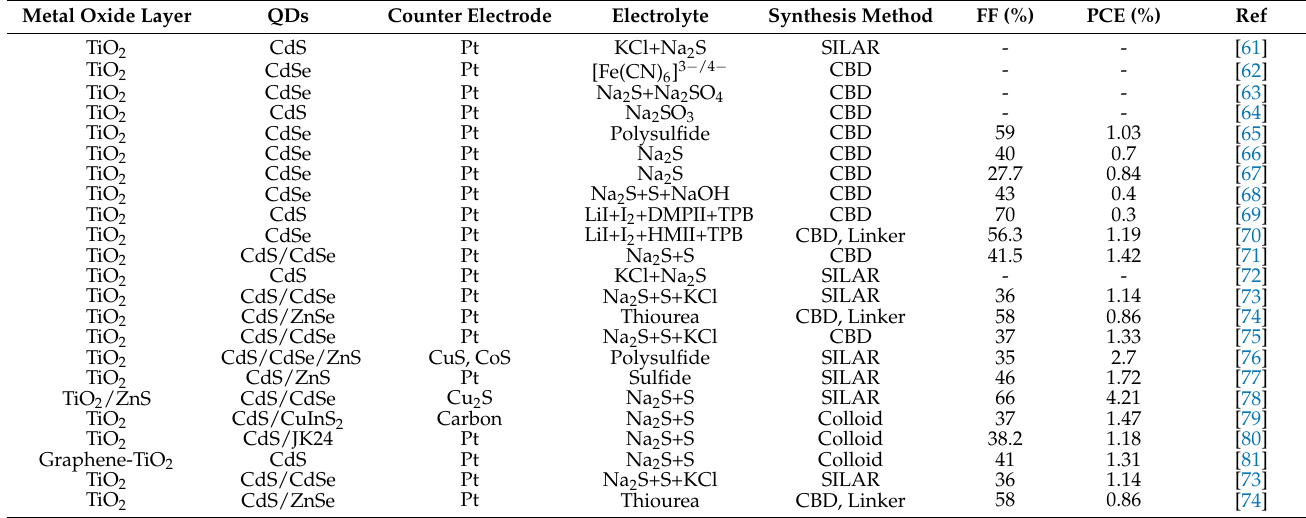
Table 1. Review of the same field publications.